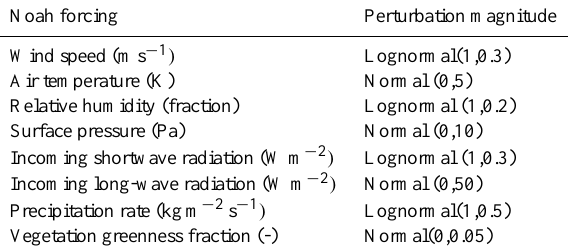
Table 2. Perturbation magnitudes of meteorological inputs used by Noah for individual ensemble members in this study. The pertur- bation distribution is either Lognormal (i.e., multiplying the ref- erence variable) or Normal (i.e., adding to or subtracting from a reference value). Values within parentheses correspond respectively to mean and standard deviation. Notice, vegetation greenness frac- tion has been added to the list given its strong sensitivity in Noah (Miller et al., 2006). The adopted magnitude values follow stan- dard procedures described in the literature, including Dunne and Entekhabi (2005), Kumar et al. (2012), Margulis et al. (2002), Re- ichle and Koster (2004), Reichle et al. (2008, 2007, 2002), Sabater et al. (2007), Walker and Houser (2004), Zhang et al. (2010), and Zhou et al. (2006).